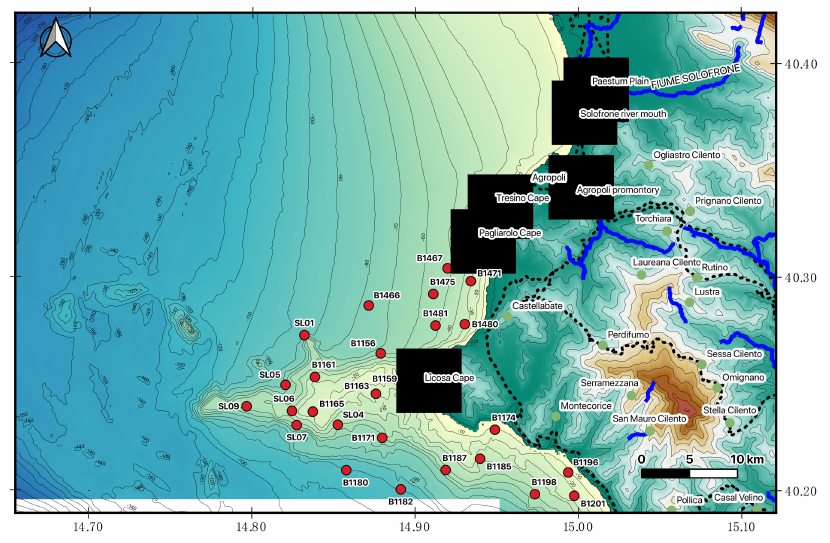
Figure 4. Location of sea bottom samples superimposed on onshore–offshore DEM of the Cilento